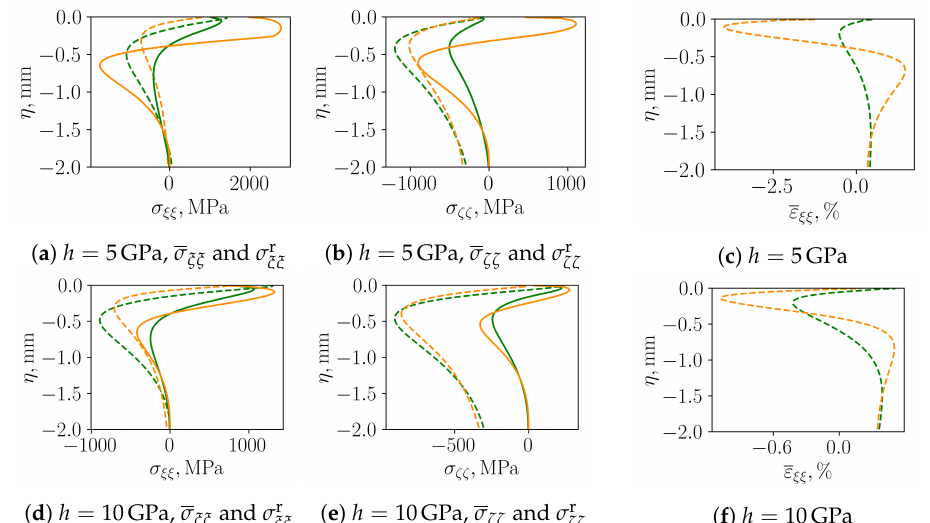
Figure 14. Left and middle column: Depth profiles of the residual stresses σ r the corresponding stress components σ ξξ , σ ζζ at the end of the loading pass (dashed lines). Right column: Normal strain ε ξξ at the end of the loading pass. The two cases h = 5GPa and h = 10GPa = 3.2kN are considered, and the orange and green colors correspond to results from the for p ∗ 0 (implicitly integrated) JS algorithm and the FE analyses,